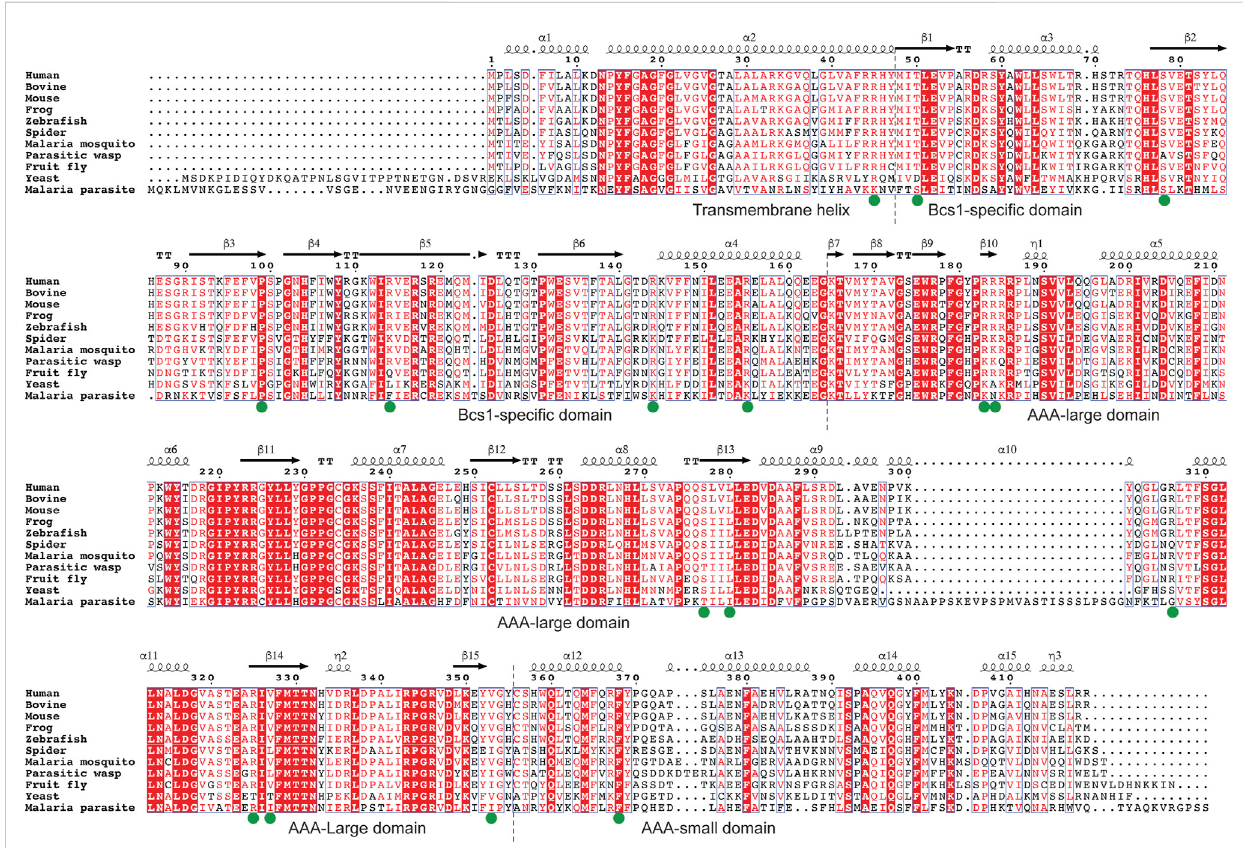
Multiple sequence alignment of Bcs1. Residues with pathogenic mutations implicated in diseases such as GRACILE syndrome, Björnstad syndrome and bc 1 complex de fi ciencies are marked with a green dot. Protein sequences were retrieved from the Uniprot with the accession numbers shown in parentheses: Human (Q9Y276), Bovine (Q5E9H5), Mouse (Q9CZP5), African clawed frog (Q7ZTL7), Zebra fi sh (Q7ZV60), House spider (A0A2L2YIU0), African Malaria Mosquito (A0A182RX69), Parasitic wasp (A0A7M7PZM7), Fruit fl y (Q9VL22), Baker ’ s yeast (P32839), Malaria parasite P.